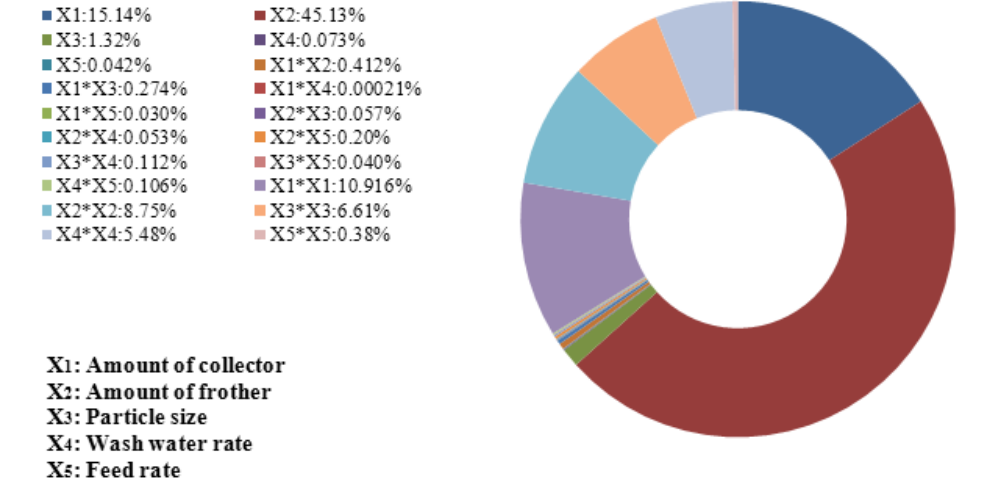
Fig. 2 . Linear, interactive and quadratic effect of process variables on ash removal from bitumen.